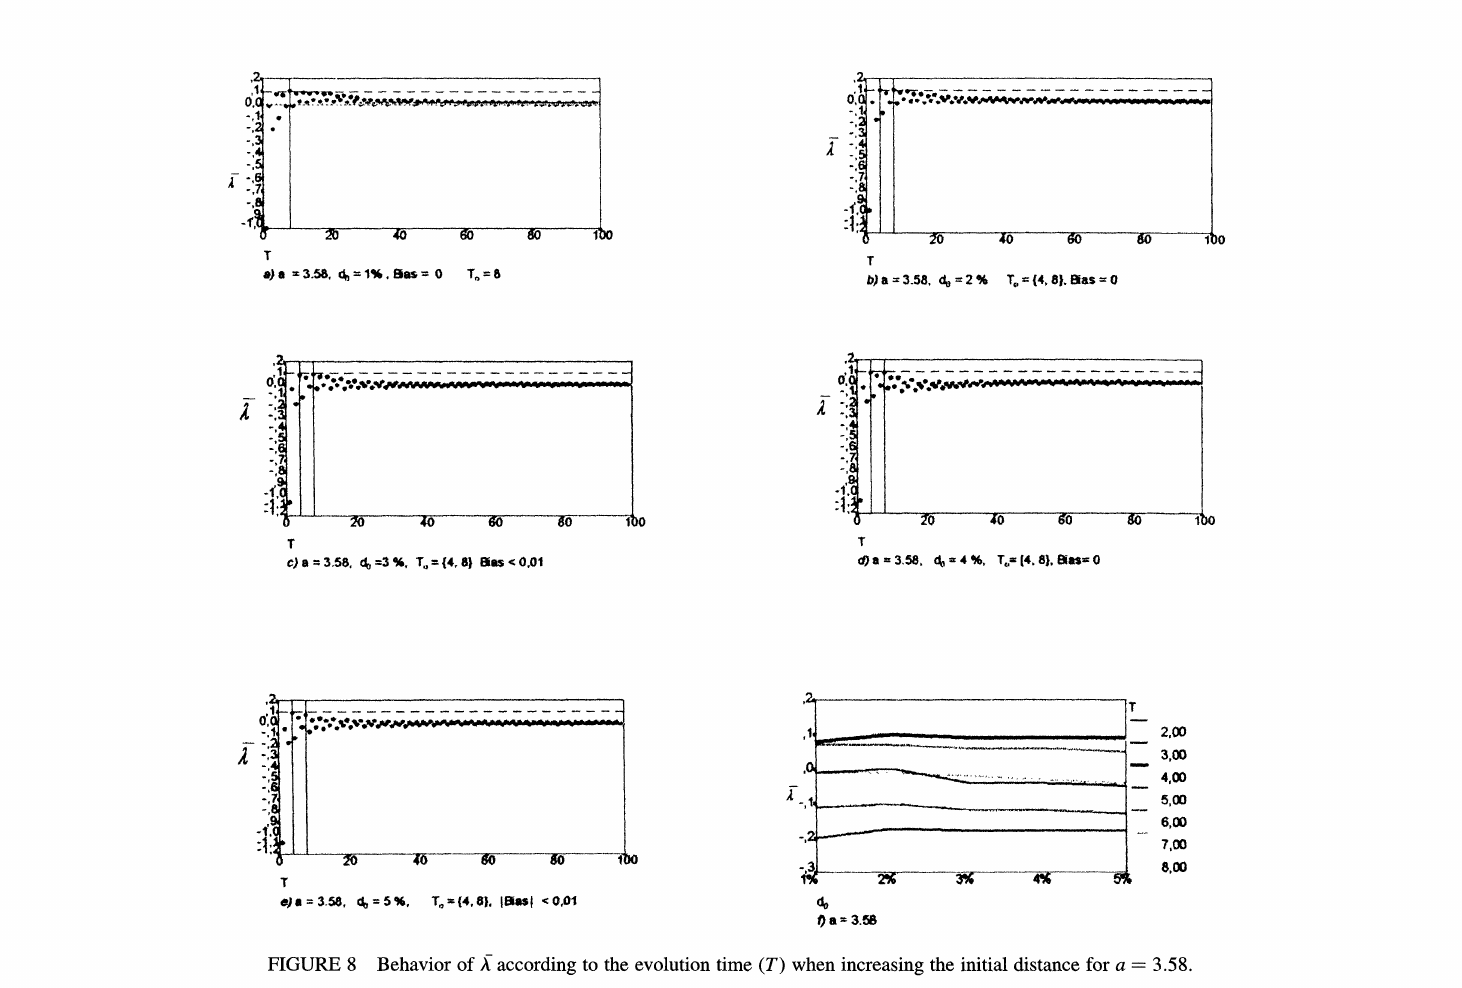
FIGURE 8 Behavior of X according to the evolution time (T) when increasing the initial distance for